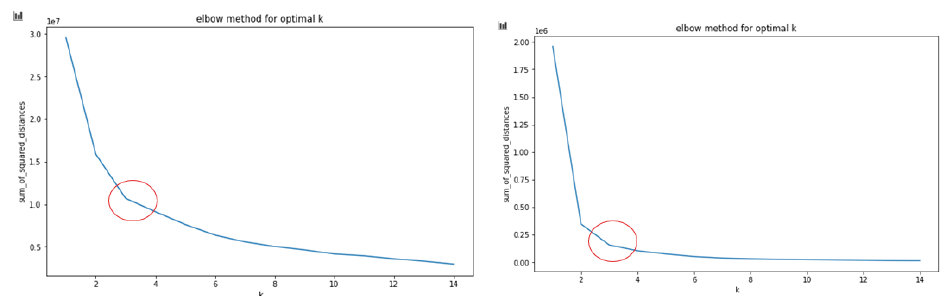
Figure 9. Result of the elbow method for continuous variables ( left ) and for discrete variables ( right ).